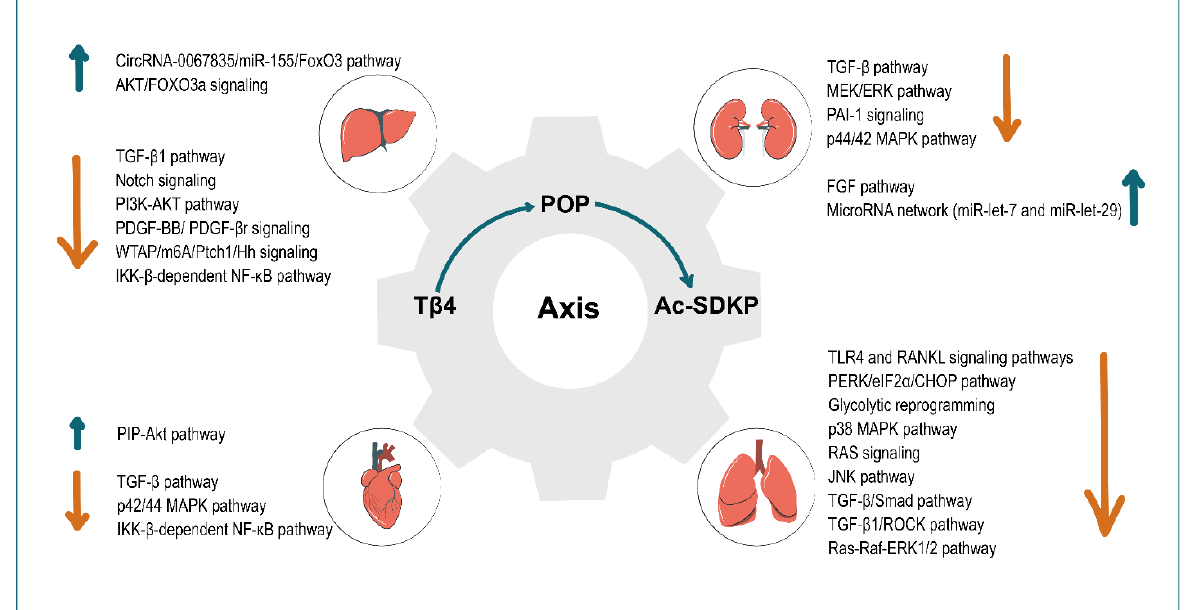
Figure 2. The signaling pathways regulated by Tβ4 -POP-Ac-SDKP axis to inhibit liver, kidney, heart, and lung fibrosis. Up arrow represents upregulation, down arrow represents downregulation. Note: TGF- β, transforming growth factor- β; WTAP, Wilms’ tumour 1-associated protein; m6A, N6-methyladenosine; Hh, Hedgehog; NFκB, nuclear factor- κB; circRNA, circular RNA; miRNA microRNA; PDGF, platelet-derived growth factor; FGF, fibroblast growth factor; MAPK, mitogen-activated protein kinase; PAI-1, plasminogen activator inhibitor-1; PIP, PINCH-1-ILK- α -parvin; Smad, Suppressor of Mothers Against Decapentaplegic Miscellaneous; ROCK, Rho-associated coiled-coil forming protein kinase; JNK, c-jun N-terminal kinase; RAS, renin – angiotensin system; TLR4, toll-like receptor 4; RANKL, receptor activator of nuclear factor kappa-B ligand.